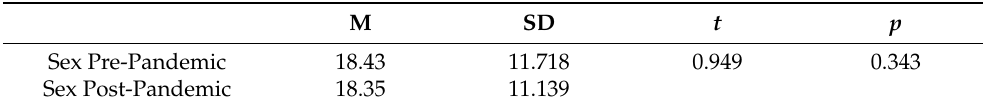
Table 3. Paired t -test related to time dedicated to the use of pornographic material, both online and not, before and after the pandemic.